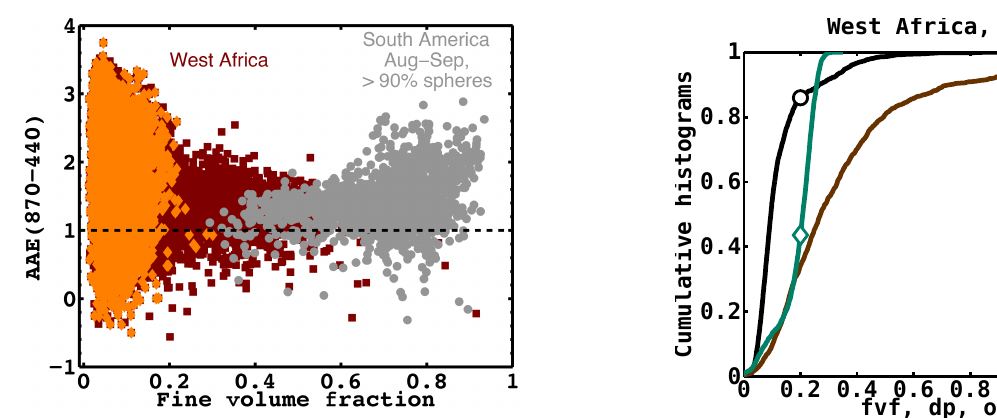
Figure 8. Cumulative histograms for the fine volume fraction (fvf), linear depolarization ratio (dp), and Ångström exponent (AE) at the West African sites; subsampled for AAE ≤ 1 . 0, which is 11% of successful Level 2.0 retrievals. The symbols indicate that 86% of the fvf are less than 0.2, 56% of the dp are greater than 0.2, and 94% of the AE are less than 1.0. This indicates that most of the West African data with AAE ≤ 1 are dominated by coarse mode dust and that low AAE does not indicate pure